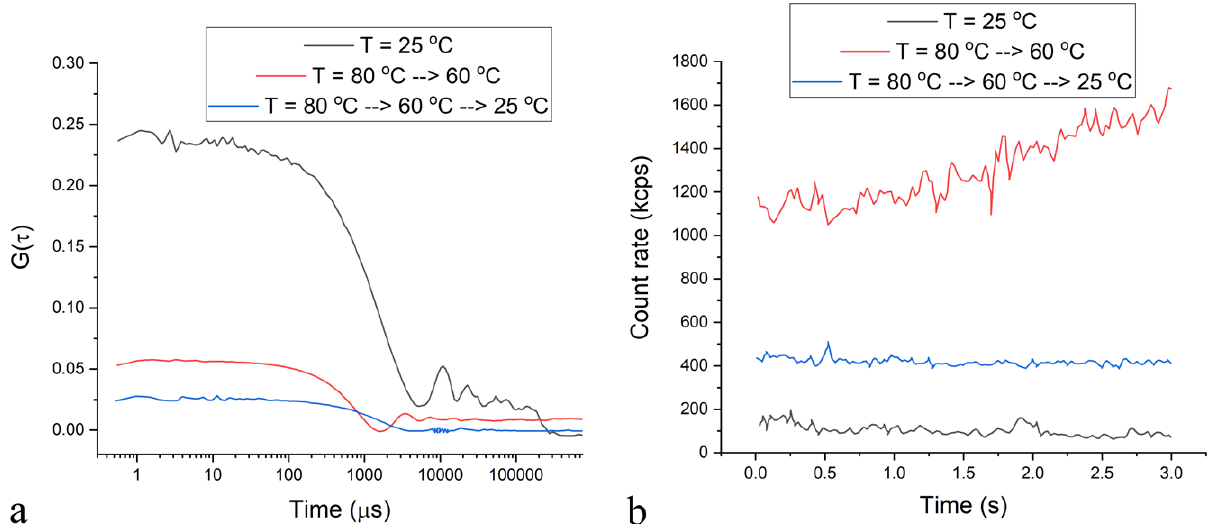
Figure 8. DLS correlation curves (a) and count rate curves (b) for DI water maintained at room temperature (25 o C) and DI water heated to 80 o C and measured first when it cooled down to 60 o C (T = 80 o C → 60 o C) and then when it cooled down to room temperature (T = 80 o C → 60 o C → 25 o C).